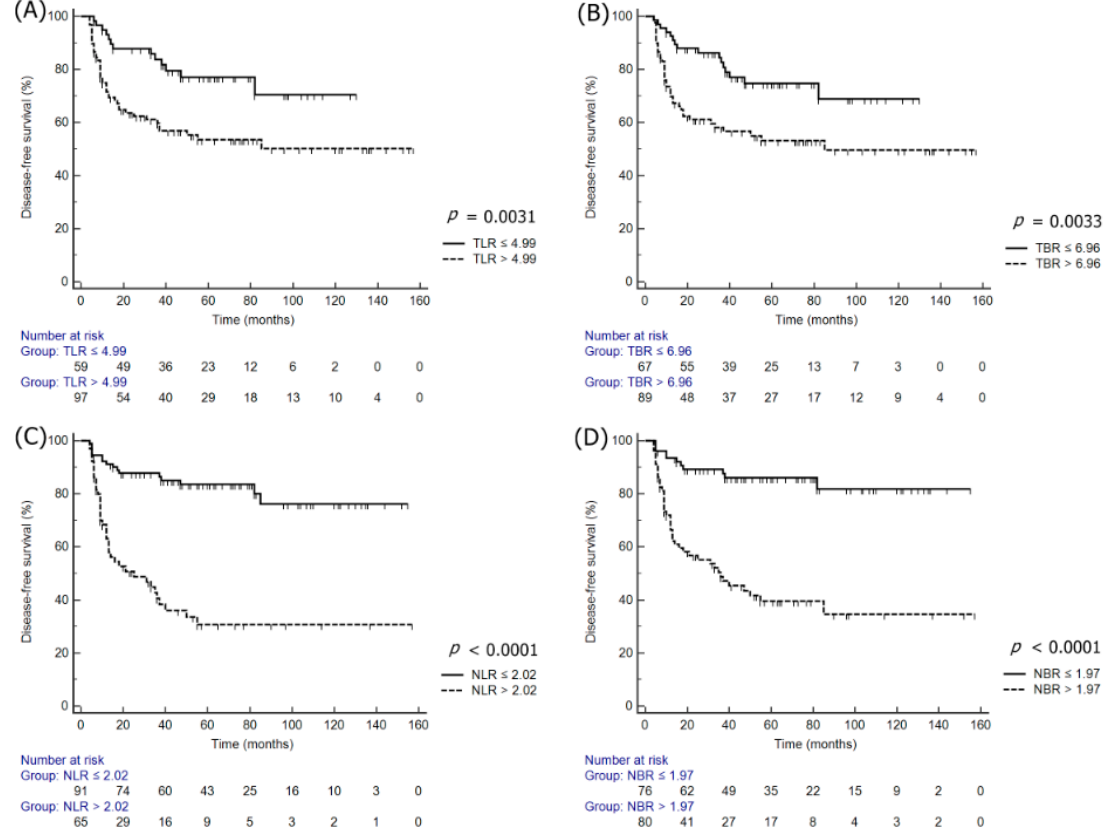
Figure 1. Kaplan–Meier survival plots of DFS according to the normalized tSUV max and nSUV max to the liver or blood: ( A ) TLR, ( B ) TBR, ( C ) NLR, and ( D ) NBR.